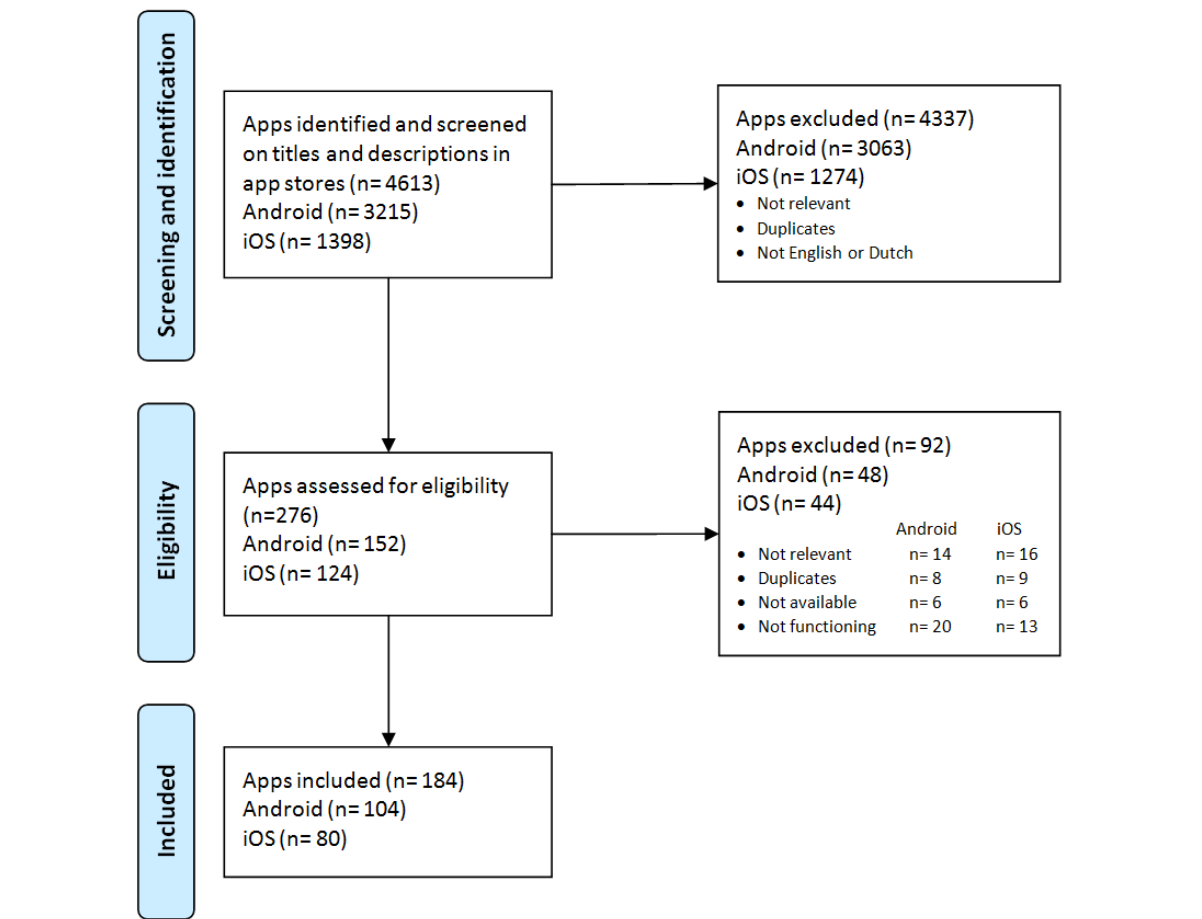
Figure 1. Flow diagram of the review and selection